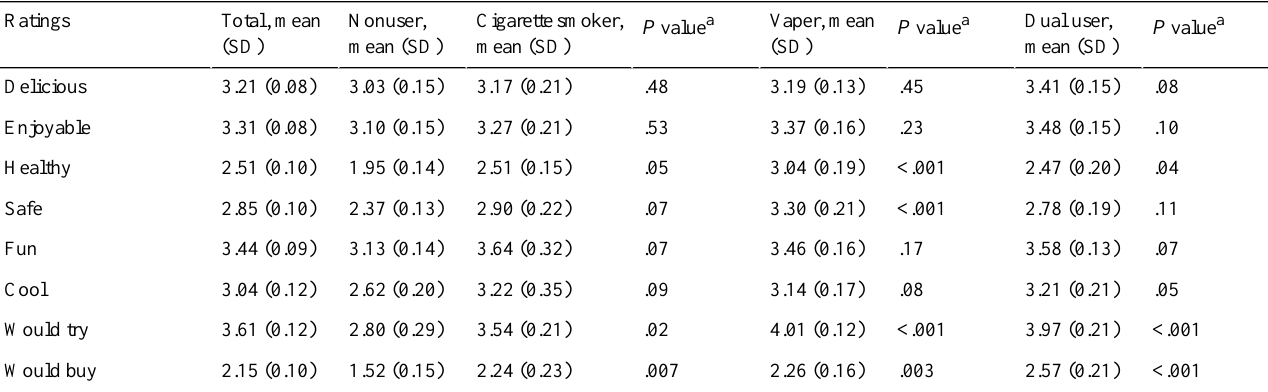
Table 3. Ratings of the electronic cigarette refill liquids by smoking